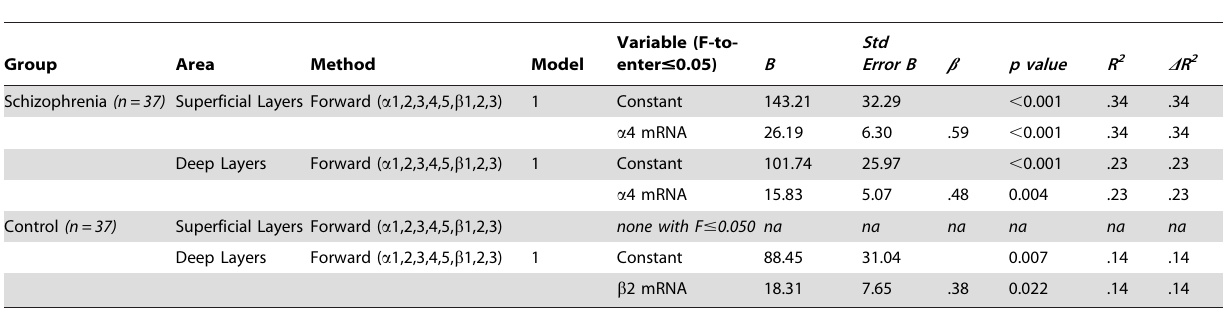
Table 4. Regression modelling of the interaction between relevant GABA A R subunits ( a and b ) and [ 3 H]Muscimol binding.